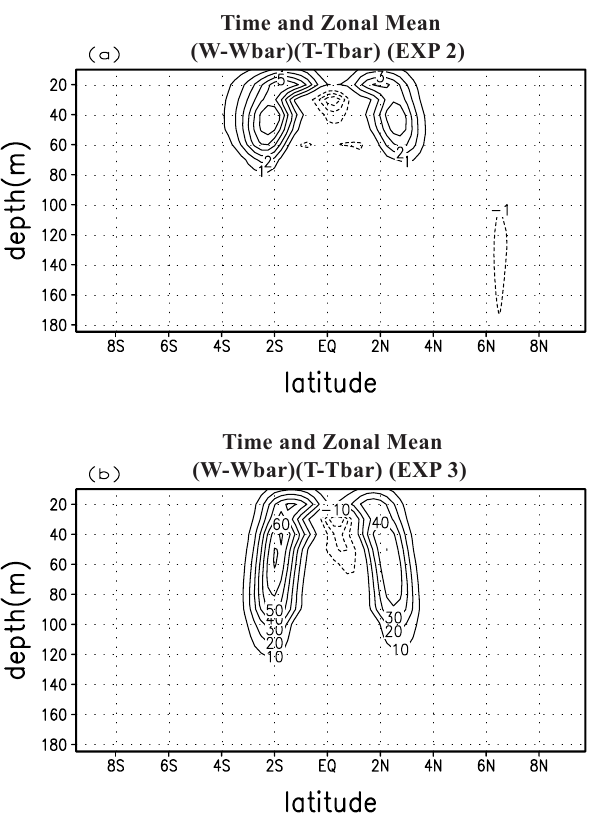
Fig. 3. Depth-latitude sections of temporally and zonally averaged w 0 T 0 for: (a) EXP 2 and (b) EXP 3. Values are multiplied by 10 6 in both panels and the contour intervals are 1cm ◦ C/s in (a) and 10cm ◦ C/s in